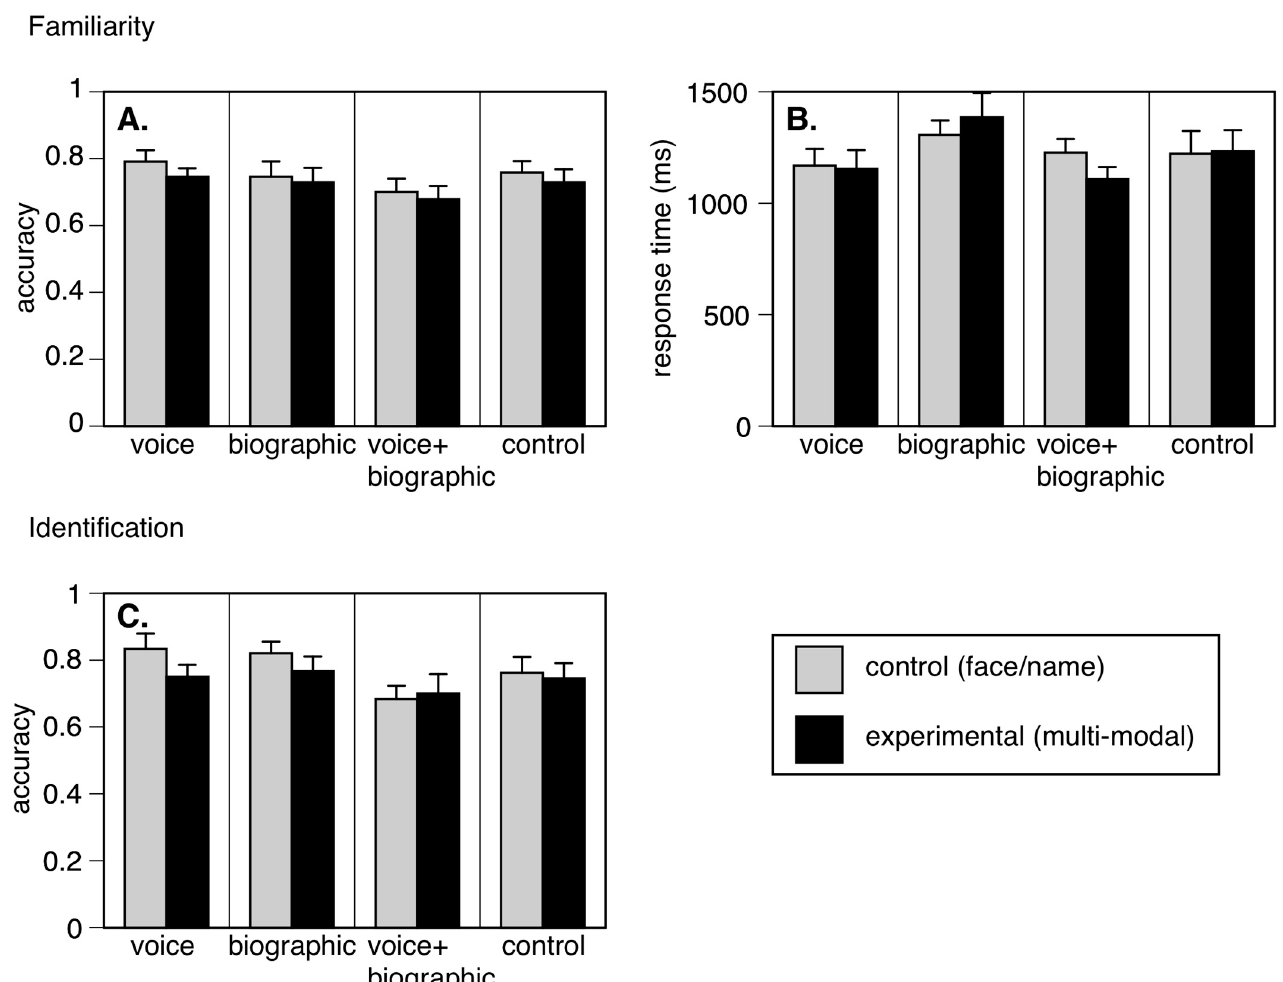
Figure 2. Results ( A ) Familiarity accuracy, ( B ) Familiarity response time, and ( C ) Identification accuracy. Each graph shows results for the four experiments separately (Voice, Biographic, Voice + Biographic, and Control). The bars compare mean performance of learning the face alone with learning the face accompanied concurrently with the additional information appropriate to that experiment. Error bars show one standard error.